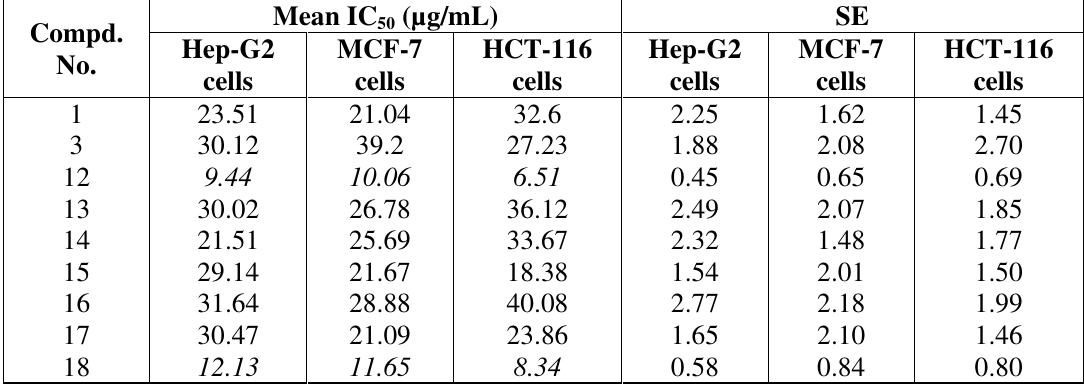
Table 1. Cytotoxicity test using MTT assay against three different human cancer cell lines. Compd.